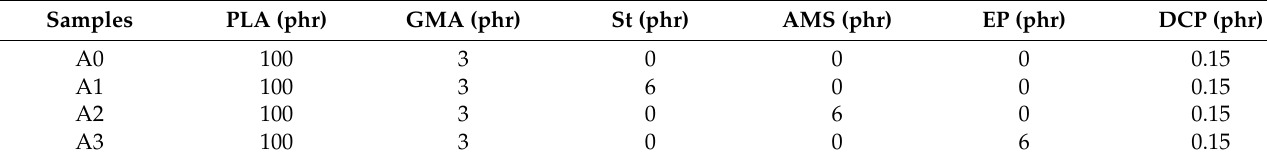
Table 1. The recipe of the PLA-g-GMA graft